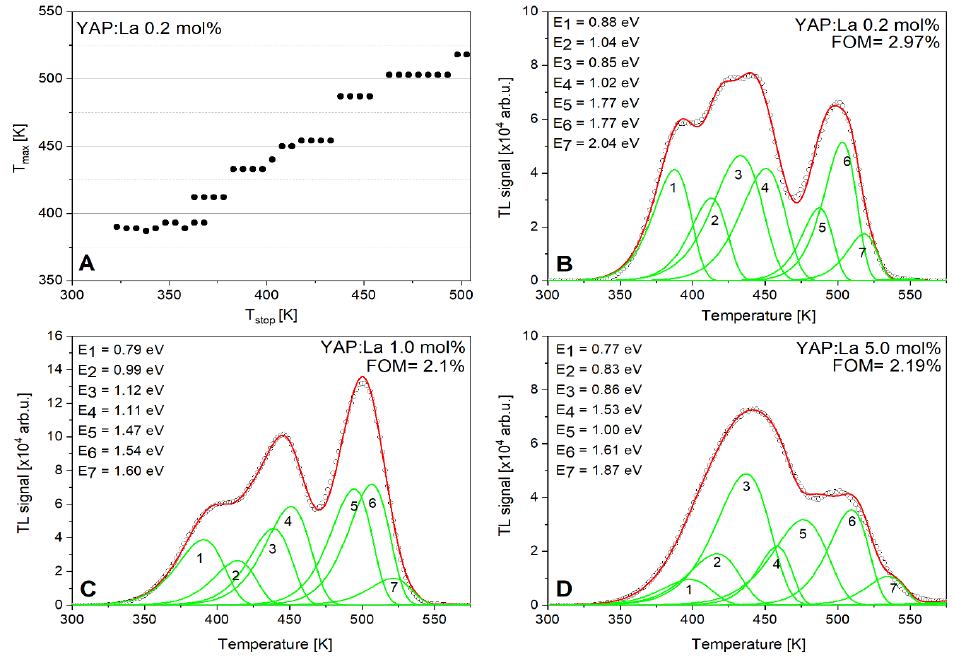
Figure 9. ( A ) An exemplary result of the T stop –T max procedure applied for the studied samples. ( B, C, D ) The results of deconvolution performed for La 3+ -doped YAlO 3 crystals with different dopant concentrations.